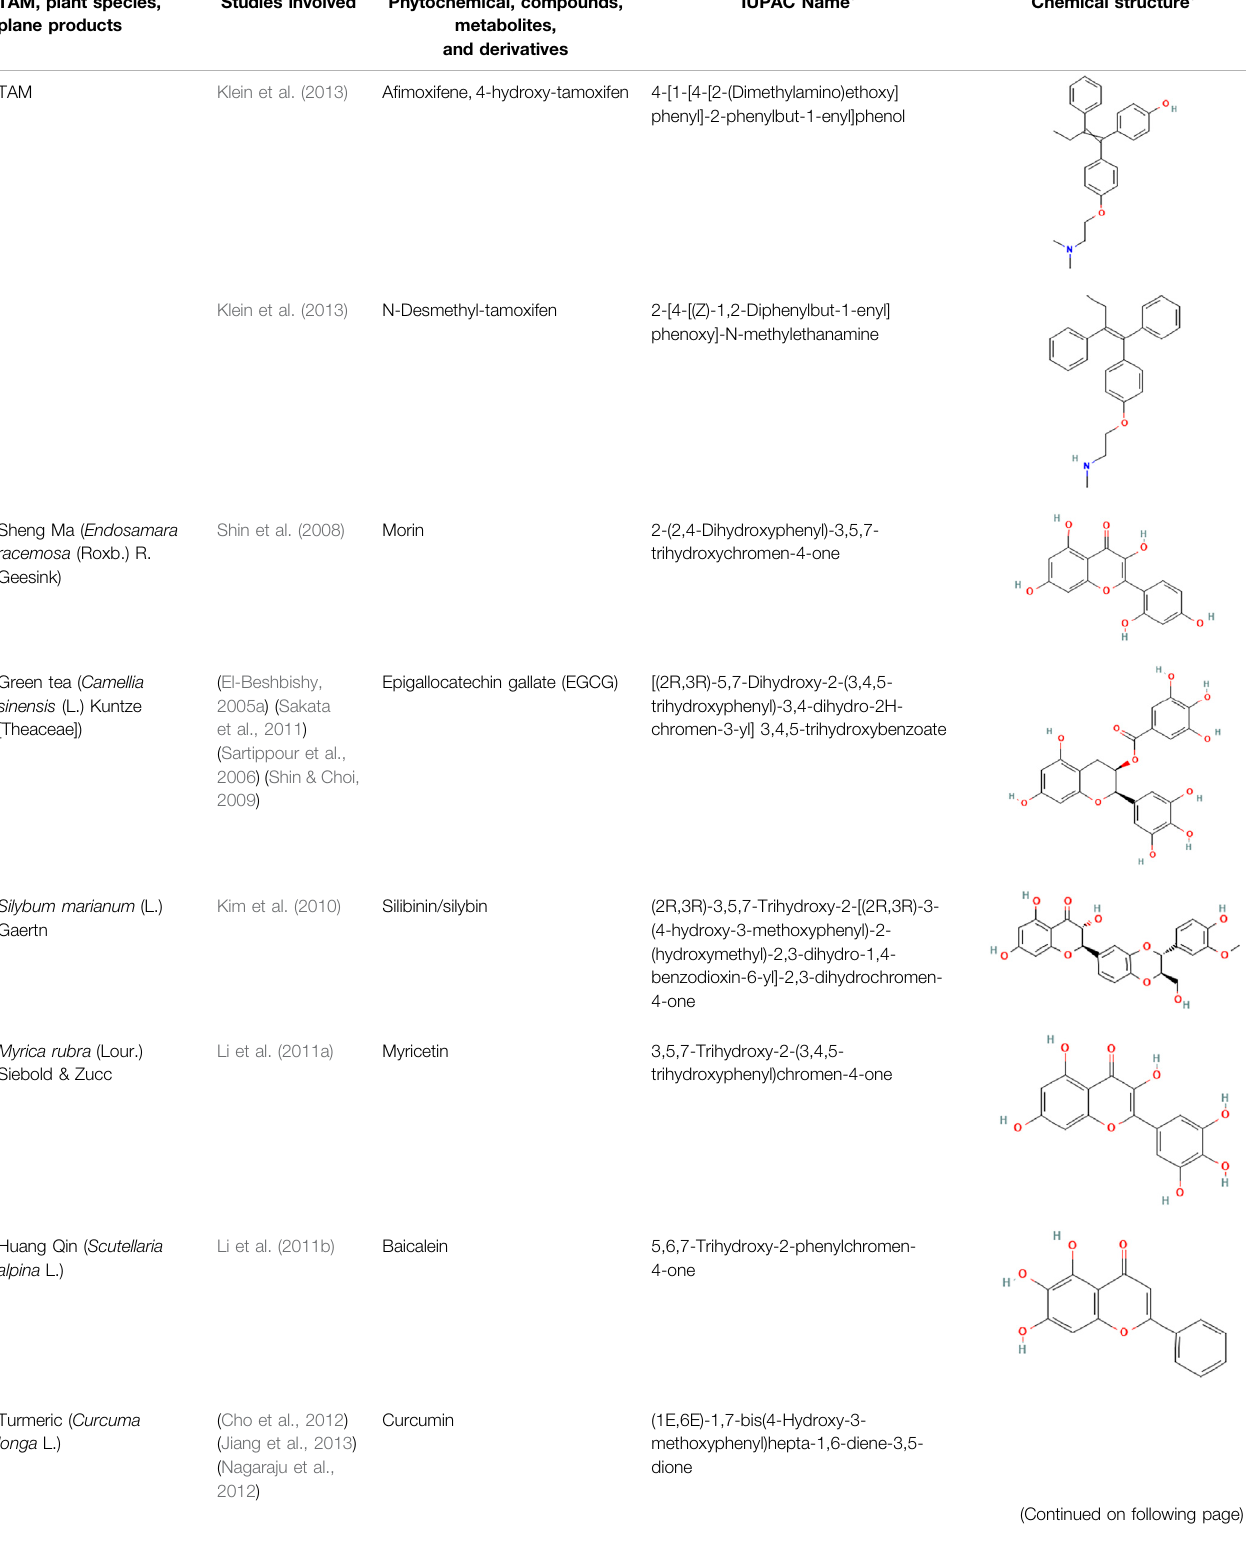
TABLE 7 | Chemical structures of TAM, phytochemicals mentioned in the review. TAM, plant species, plane